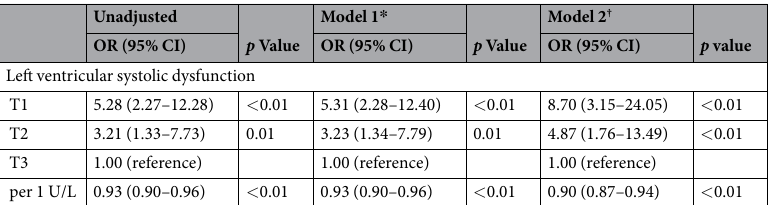
Table 3. Association between DPP4a and left ventricular systolic dysfunction in STEMI patients. * Adjusted for age and sex. † Adjusted for age, sex, body mass index, creatinine, gamma-glutamyltransferase, creatinine, MB isoenzyme of creatine kinase, pro- brain natriuretic peptide, hypertension, hyperlipemia, type 2 diabetes, smoking and previous myocardial